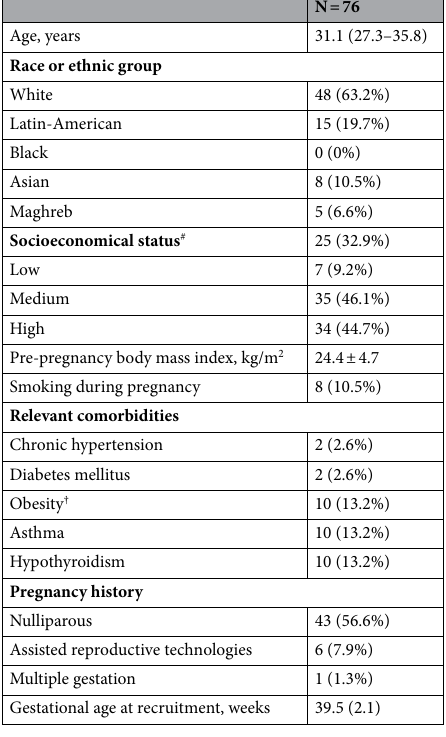
Table 1. Baseline characteristics of the study population. Data are n (%) or median (IQR) or mean ± SD. # Low socioeconomic status defined as study level (low: no studies, primary; medium: secondary; high: university). † Obesity defined as body mass index > 30 kg/m 2